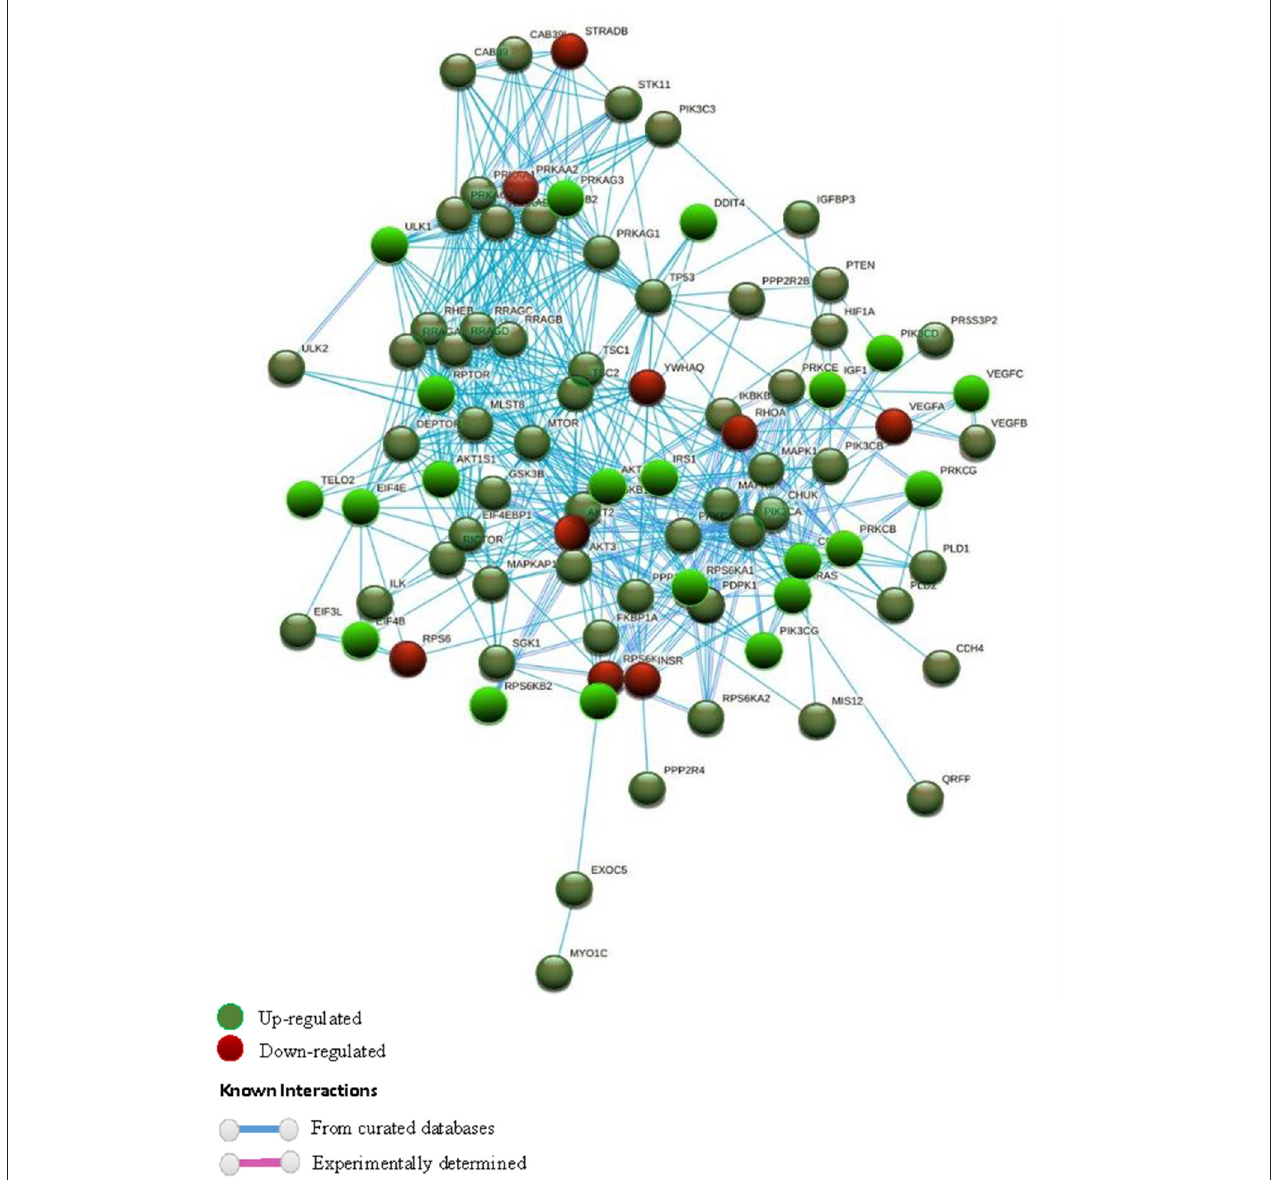
FIGURE 2 | STRING interaction pathway of differentially expressed mTOR pathway genes. Green nodes indicate up-regulated genes and red nodes down-regulated genes comparing + AMR/ + DSA and + DSA vs. –AMR/–DSA KT patients. The intensity of the color indicates the degree of regulation of the gene. The blue line shows that the interaction is checked against curated databases and the purple line shows that the interaction is experimentally determined.